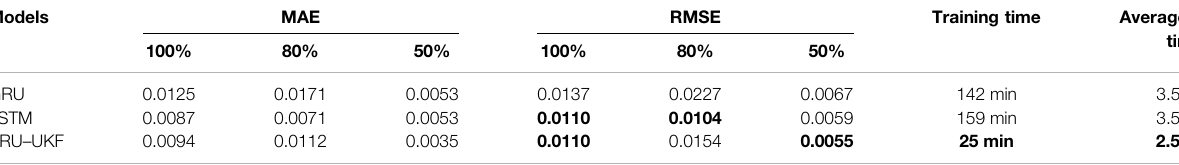
TABLE 4 | Comparison of SOC estimation among GRU, LSTM, and SRU – UKF at various initial SOC values. Models